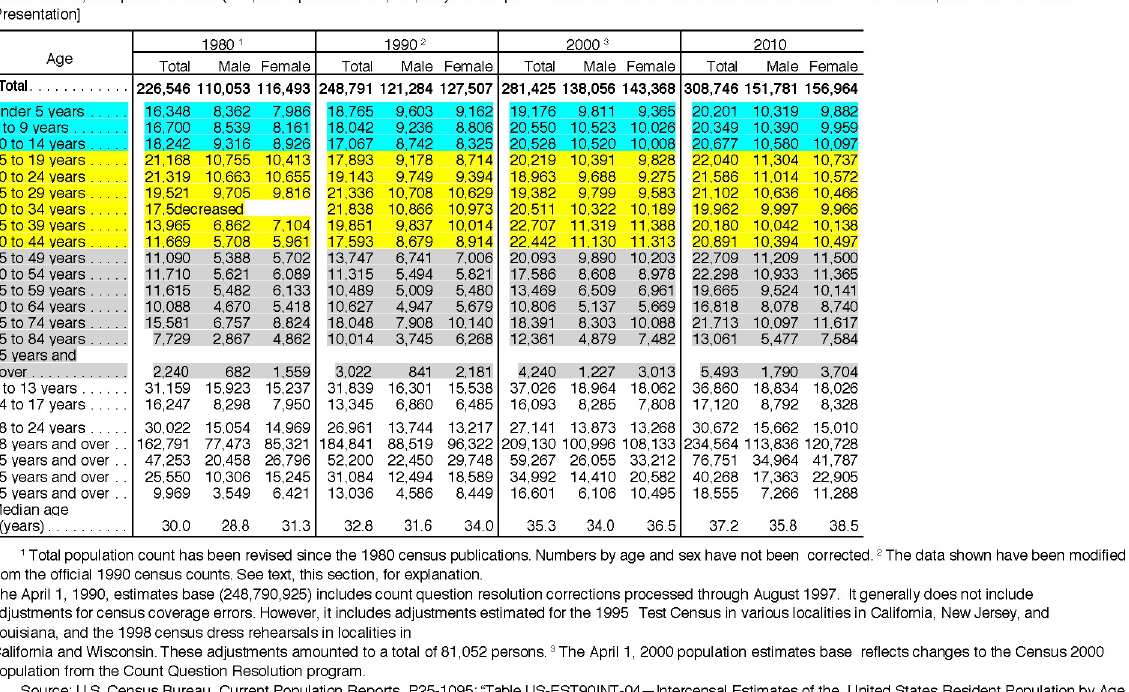
Fig 2. US census data (for each decade from 1980 to 2010) for resident population by age and sex. Age-band ( A1 ) is highlighted in turquoise; Age-band ( A2 ) is highlighted in yellow; and Age-band ( A3 ) is highlighted in grey.